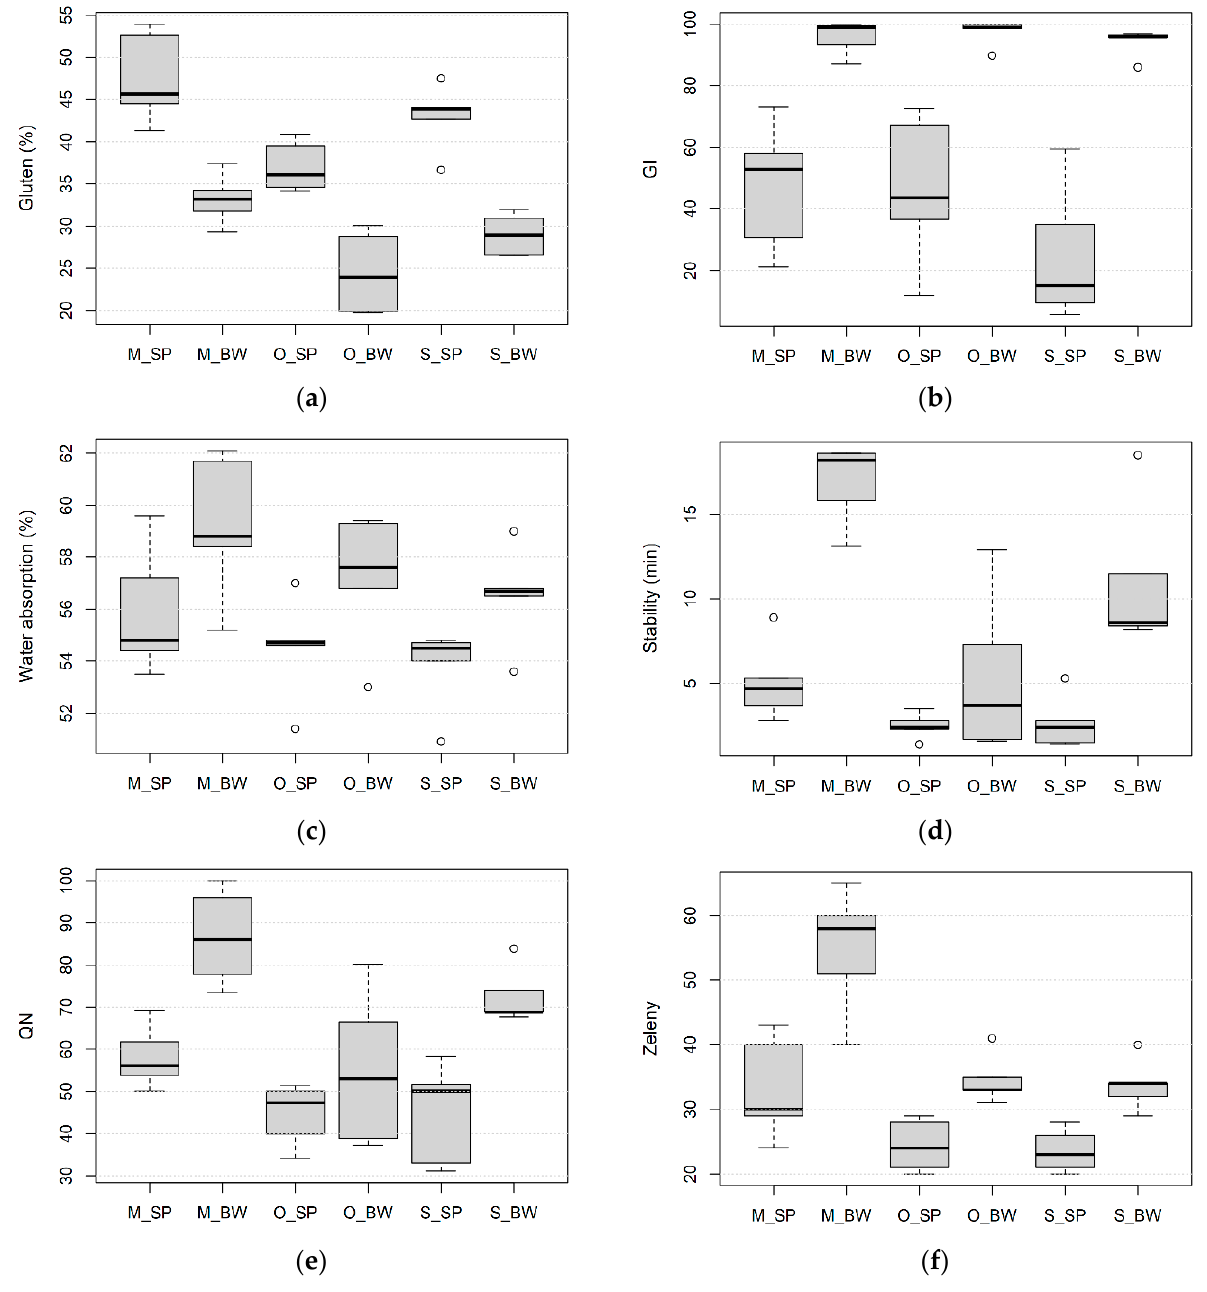
Figure 1. Boxplots for ( a ) gluten content ( b ), GI—gluten index ( c ), water absorption ( d ), dough stability time ( e ), QN— farinograph quality number ( f )—Zeleny sedimentation volume; SP—spelt wheat, BW—bread wheat, M—conventional growing site in Martonvásár Hungary, O—organic growing site in Hungary, S—conventional growing site in Serbia; minimum value excluding outliers—shown by the line at the end of the bottom whisker; the first lower quartile (25th percentile)—shown by the lower end of the box; median—shown by the horizontal line inside the box; the third upper quartile (75th percentile)—shown by the upper end of the box; maximum value excluding outliers—shown by the line at the end of the upper whisker; outliers—shown by the empty circles.